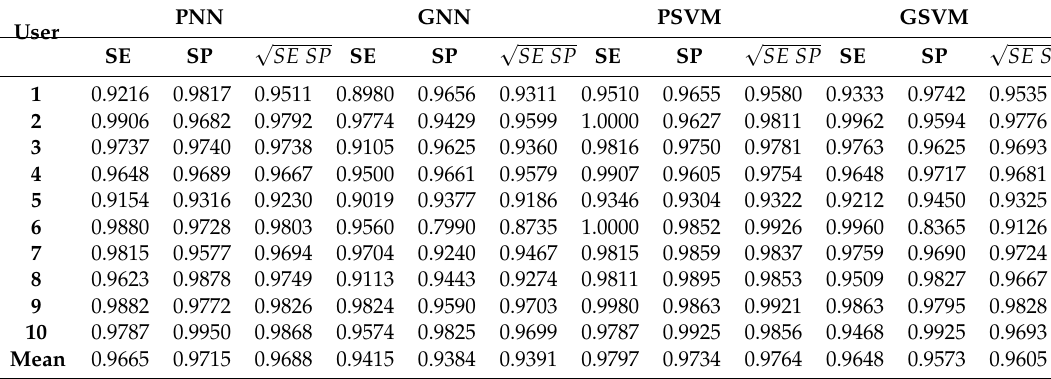
? SE SP . For each pair comparison,